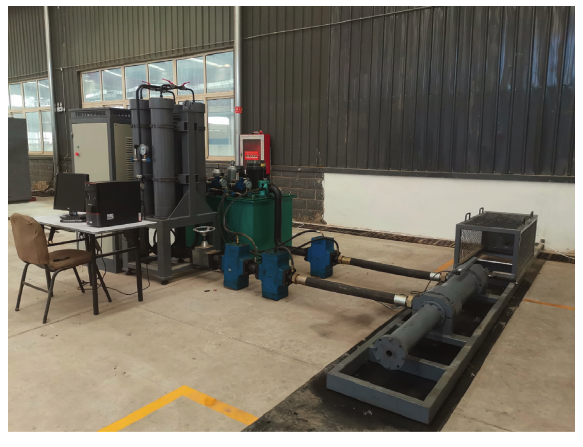
Figure 11: Force-displacement curves.